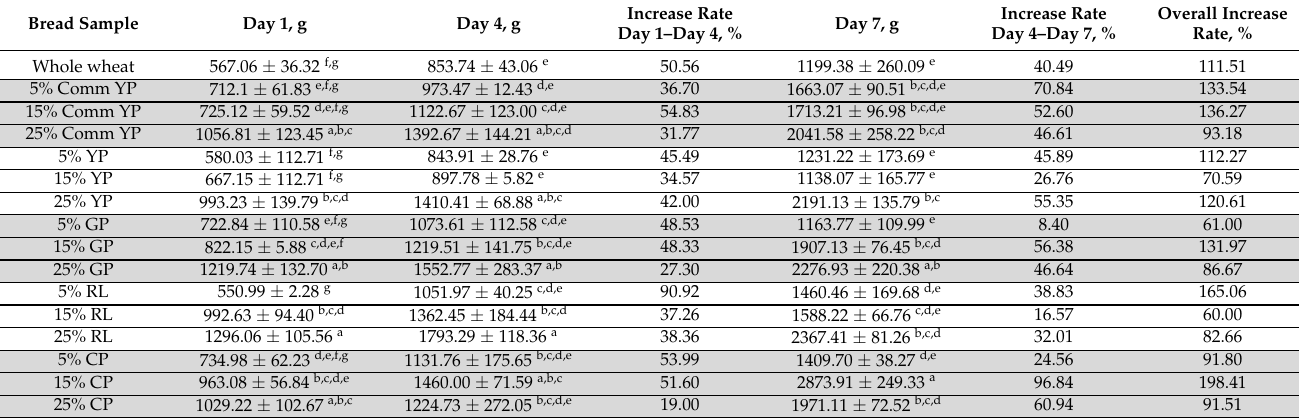
Table 7. Hardness of whole wheat/pulse bread during one-week